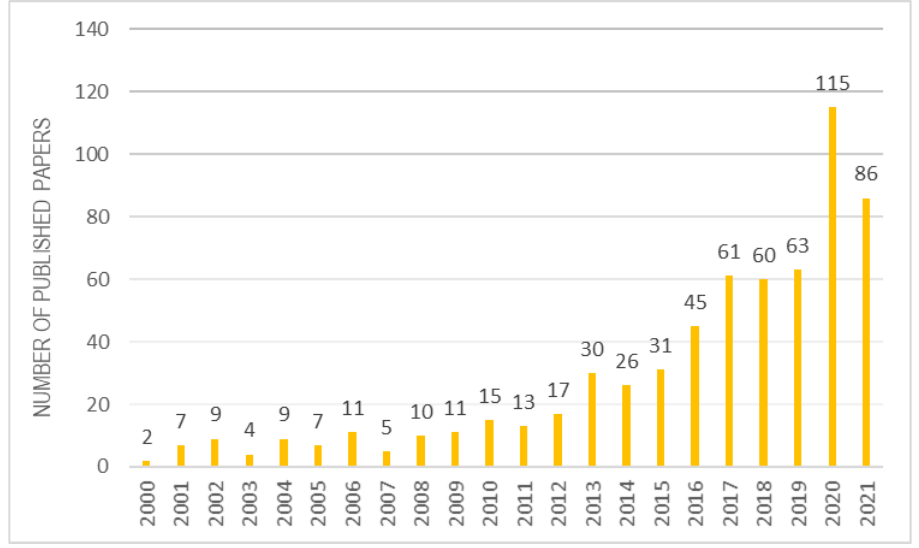
Figure 4. Studies inherent to α -tocopherol combined with biomaterials over the